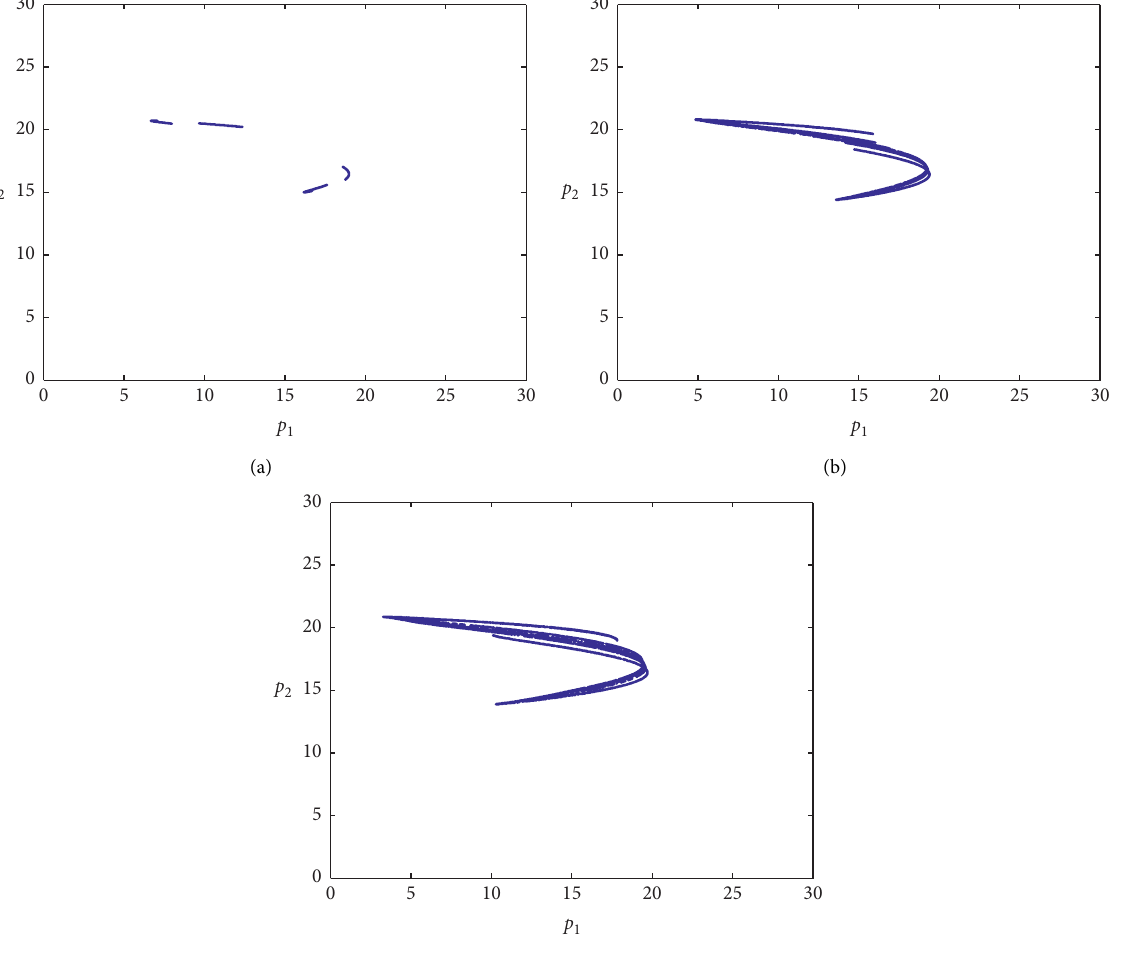
� 1. (b) v � 5. (c) v � 9. 1 1 1